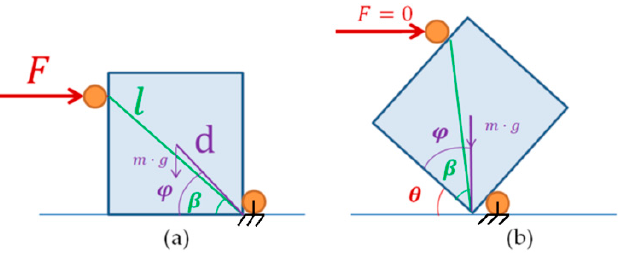
Figure 4. ( a ) Box in the resting position, with the forces represented. ( b ) Box in the equilibrium po- sition, with the weight in the vertical in relation to the rotation